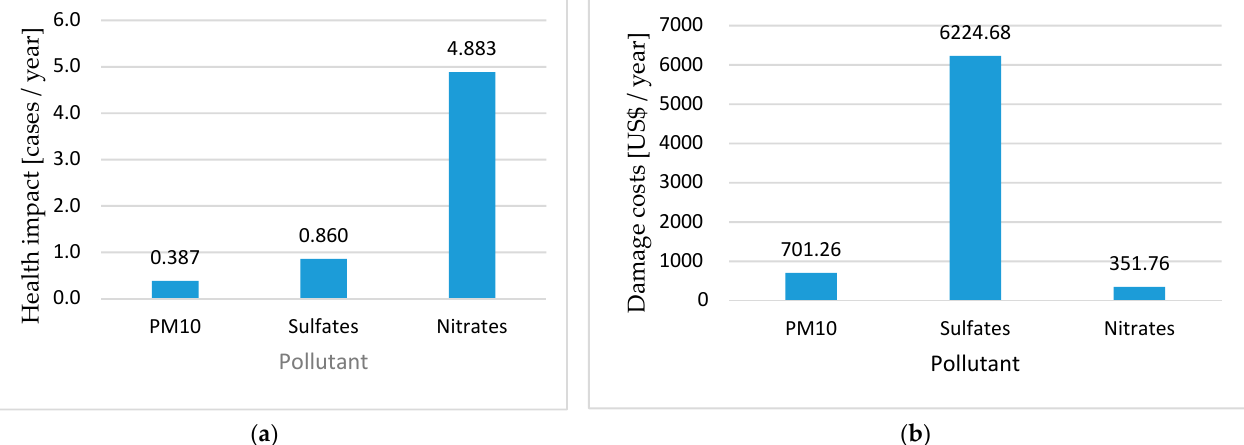
Figure 5. Environmental impacts and damage costs of the Egbin fossil power plant (FPP) in Nigeria. ( a ) SIMPACT results showing the number of cases per year affected by pollution from Egbin FPP. ( b ) SIMPACT results showing damage cost resulting from pollution generated by Egbin FPP.